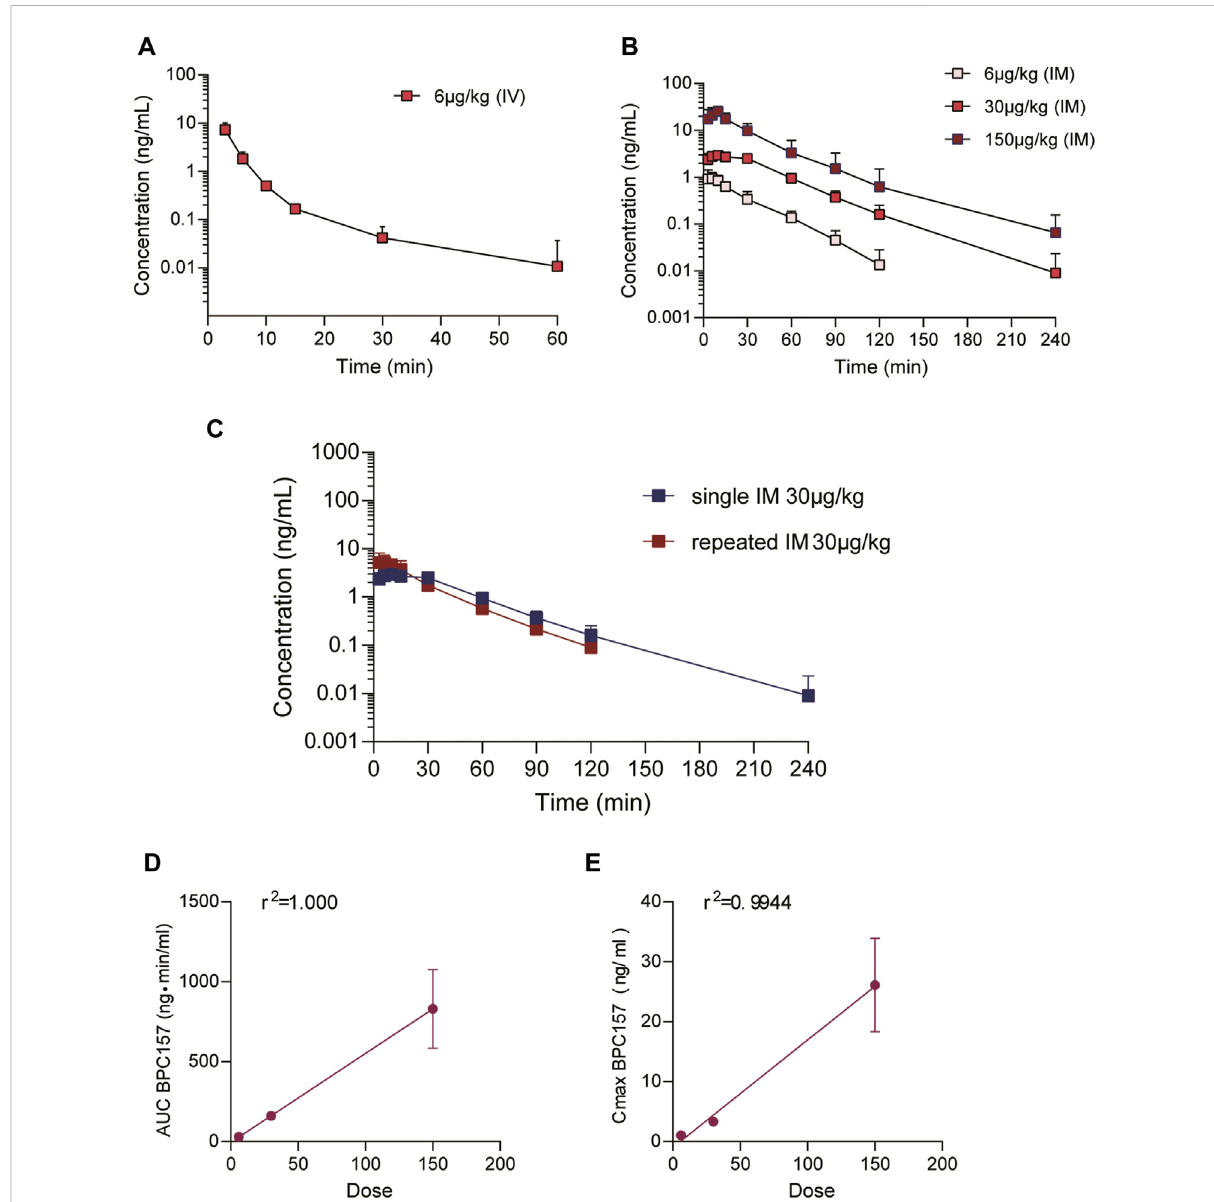
FIGURE 2 Pharmacokinetic studies of BPC157 in beagle dogs (mean ± SD, n = 6). (A) Total plasma concentration versus time pro fi les of BPC157 following intravenous administration at a dose of 6 μ g/kg; (B) Total plasma concentration versus time pro fi les of BPC157 following intramuscular administration of doses 6, 30, or 150 μ g/kg; (C) Total plasma concentration versus time pro fi les of BPC157 following repeated intramuscular administration at a dose of 30 μ g/kg for seven consecutive days (red) or a single intramuscular administration at a dose of 30 μ g/kg (blue). (D) Linearregressionanalysisbetween BPC157 AUCand dosesfollowing intramuscularadministrationofdoses6, 30,or150 μ g/kg. (E) Linearregression analysis between BPC157 C max and doses following intramuscular administration of doses 6, 30, or 150 μ g/kg. The goodness of fi t was estimated by coef fi cients of determination (r 2 ). Data are representative of three independent